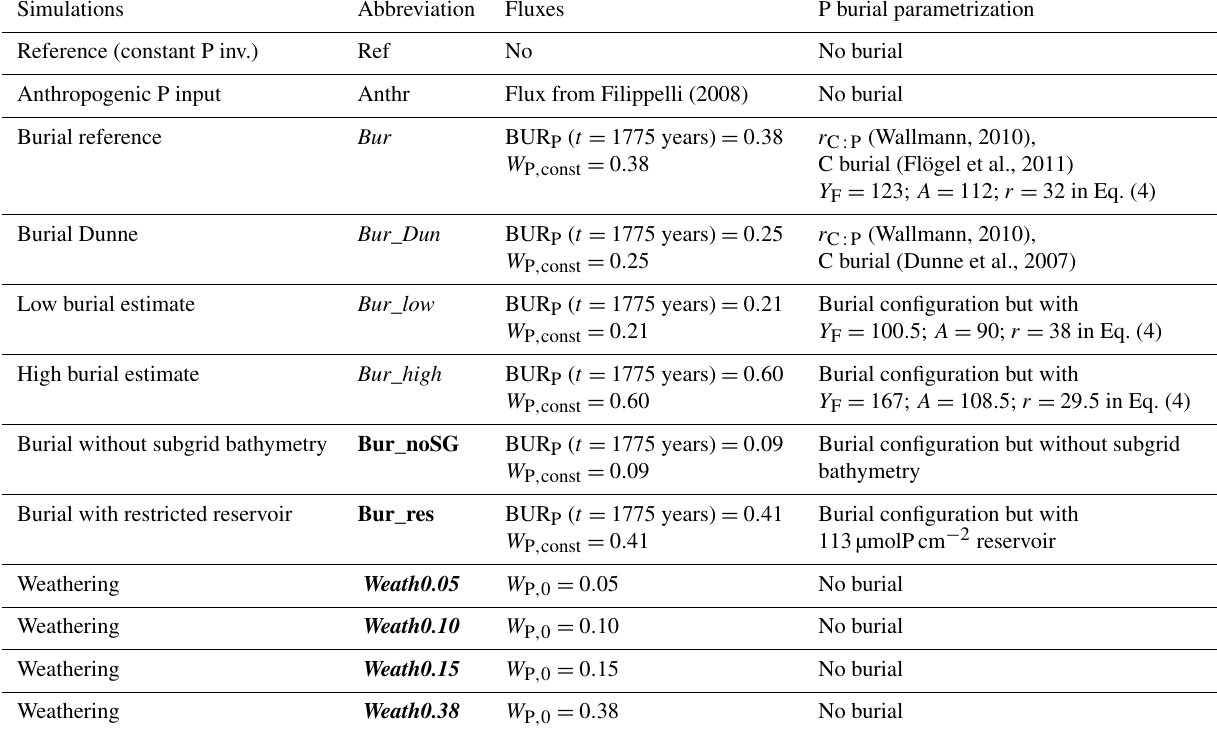
Table 1. Overview of simulations. P fluxes are given in TmolPa − 1 . We divided all simulations into four groups indicated by different colours. These are reference simulations (in roman) with and without anthropogenic fluxes of P; simulations with different formulations for the burial (in italic beginning with the abbreviation “Bur”); simulations with weathering fluxes of P for different climate sensitivities (in bold italic beginning with the abbreviation “Weath”); and simulations with different representations of the sediment (in bold). In the P weathering simulations, only weathering anomalies were applied. The weathering flux in simulation Anthr is variable over time (Fig. 2a). In the P burial simulations, a constant P weathering flux ( W P , 0 ) balances P burial (BUR P ) during the spin-up simulations. The pre-industrial P inventory is identical in all simulations. More detailed information can be found in the